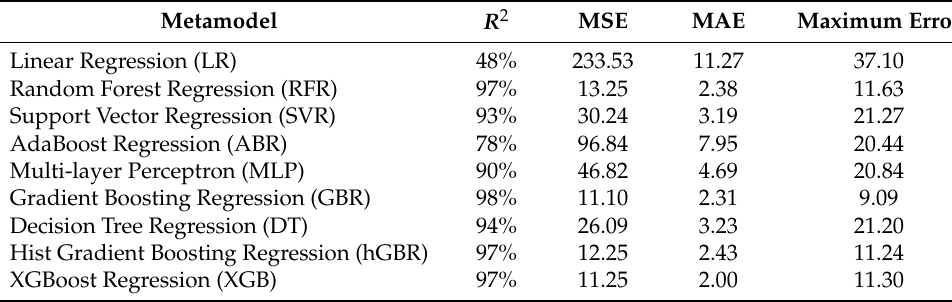
Table 3. Performance of the ML metamodels on testing data.